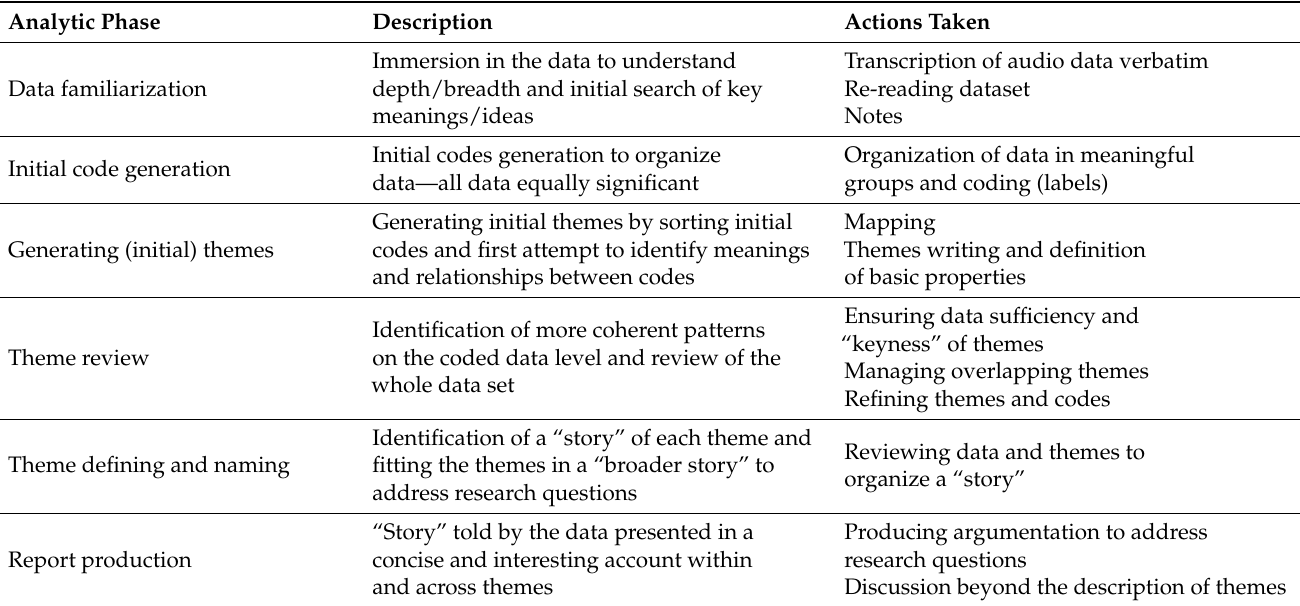
Table 2. The six phases of reflexive TA adapted from Braun and Clarke (as cited in [22] p.